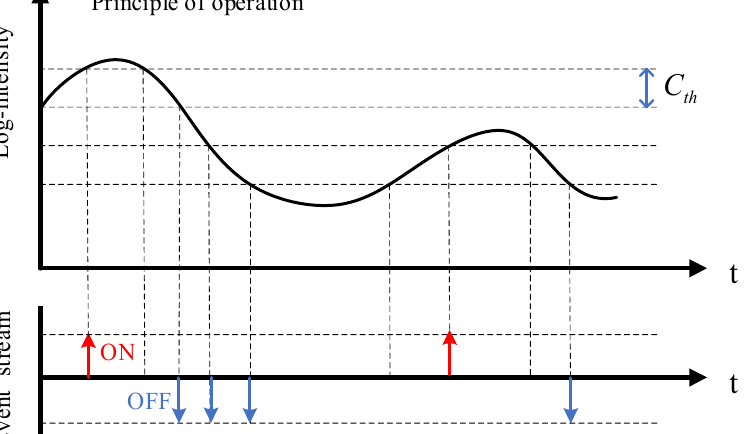
Figure 2. The process of generating events by the event camera. Each pixel acts as an independent detection unit for luminance changes, and events are generated immediately when the log intensity change at the pixel reaches the specified threshold C th . Continuous generation of events will form event streams. The event streams contain events of two polarities. When the light intensity changes from strong to weak and reaches the threshold, the camera outputs an OFF event (indicated by the blue arrow); when the light intensity changes from weak to strong and reaches the threshold, the camera outputs an ON event (indicated by the red